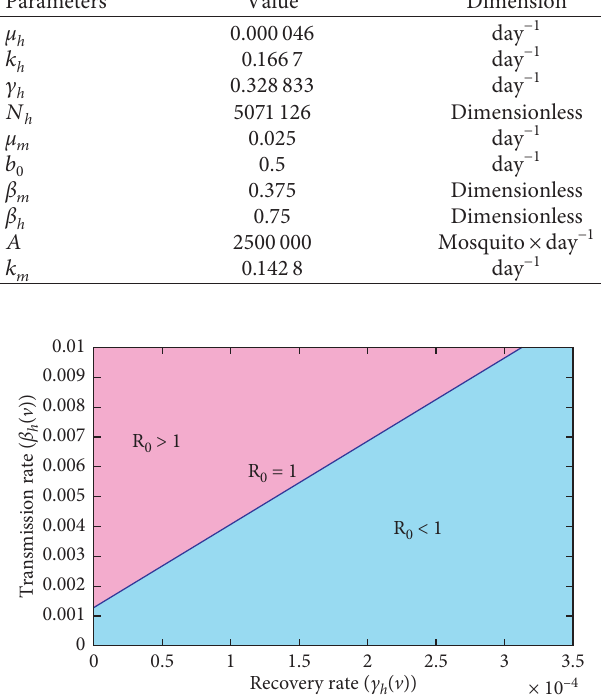
Figure 4: Sensitivity diagram of parameters β and the critical line R condition of dengue, and the blue colored area defines dengue-free condition.